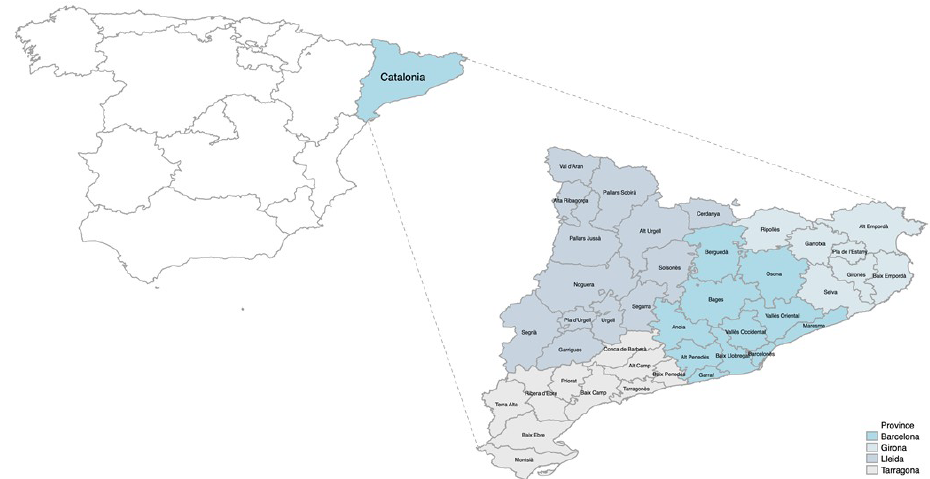
Figure 1. Counties of Catalonia and location of the region in the context of